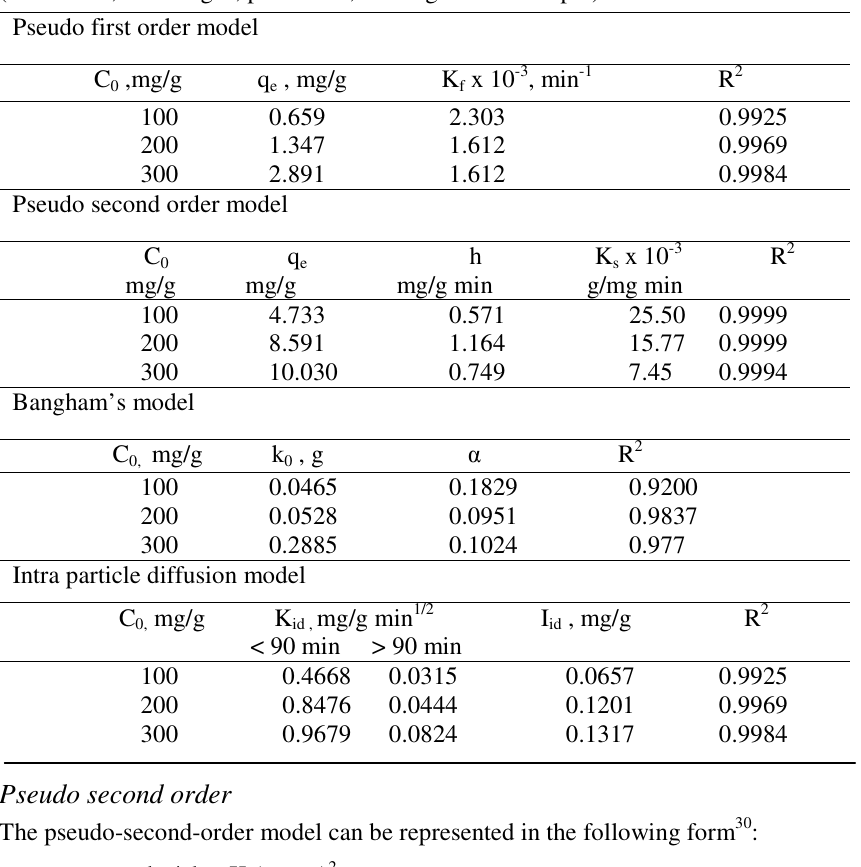
Table 4. Kinetic parameters of removal of Cu (II) by WBAP (T = 295 K, m = 20 g/L, pH = 2.46, Stirring rate = 100